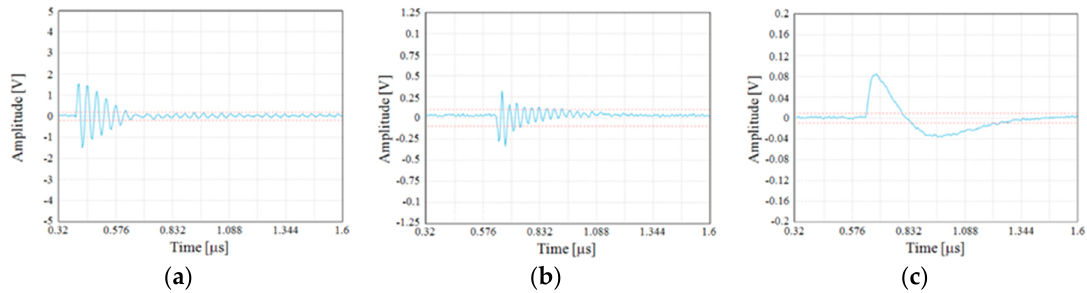
Figure 11. Single PD pulses of ( a ) internal, ( b ) surface, and ( c ) corona